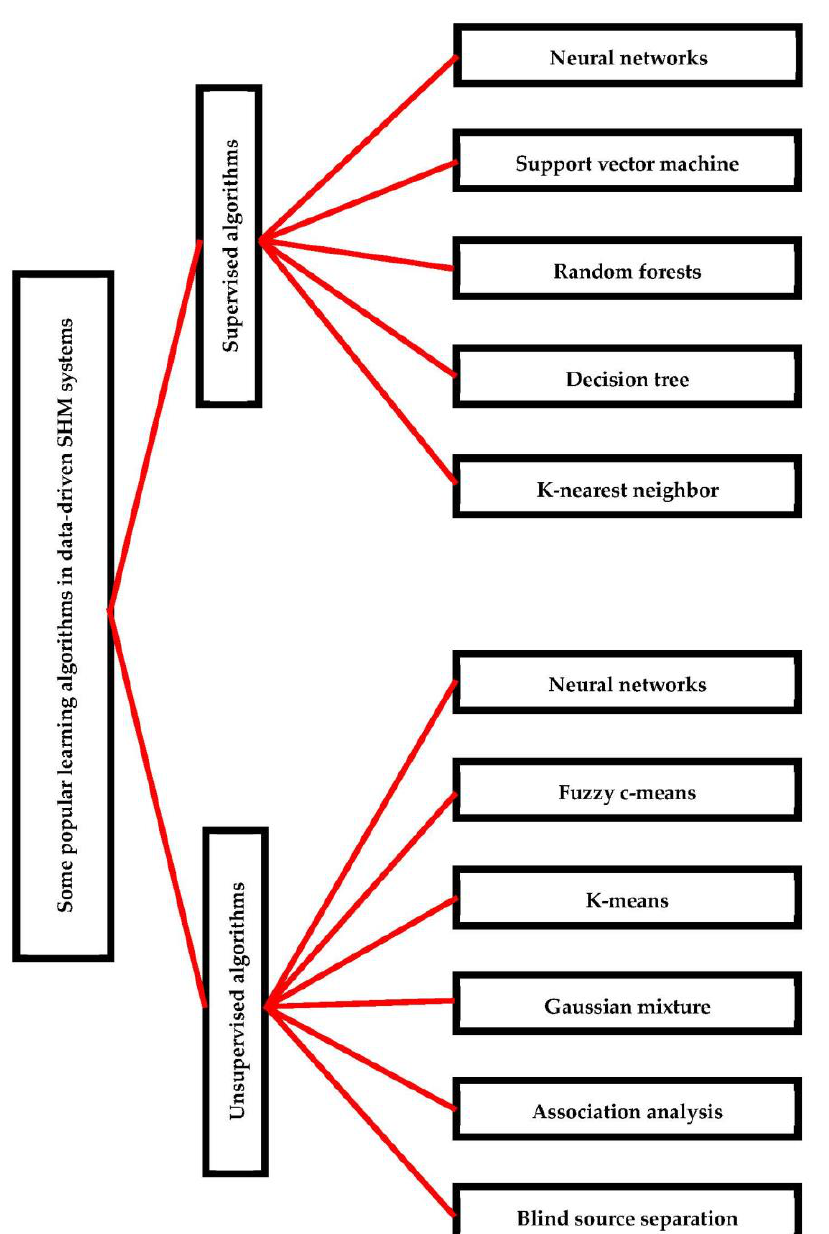
Figure 4. An overview of the most popular learning algorithms in data-driven SHM systems.